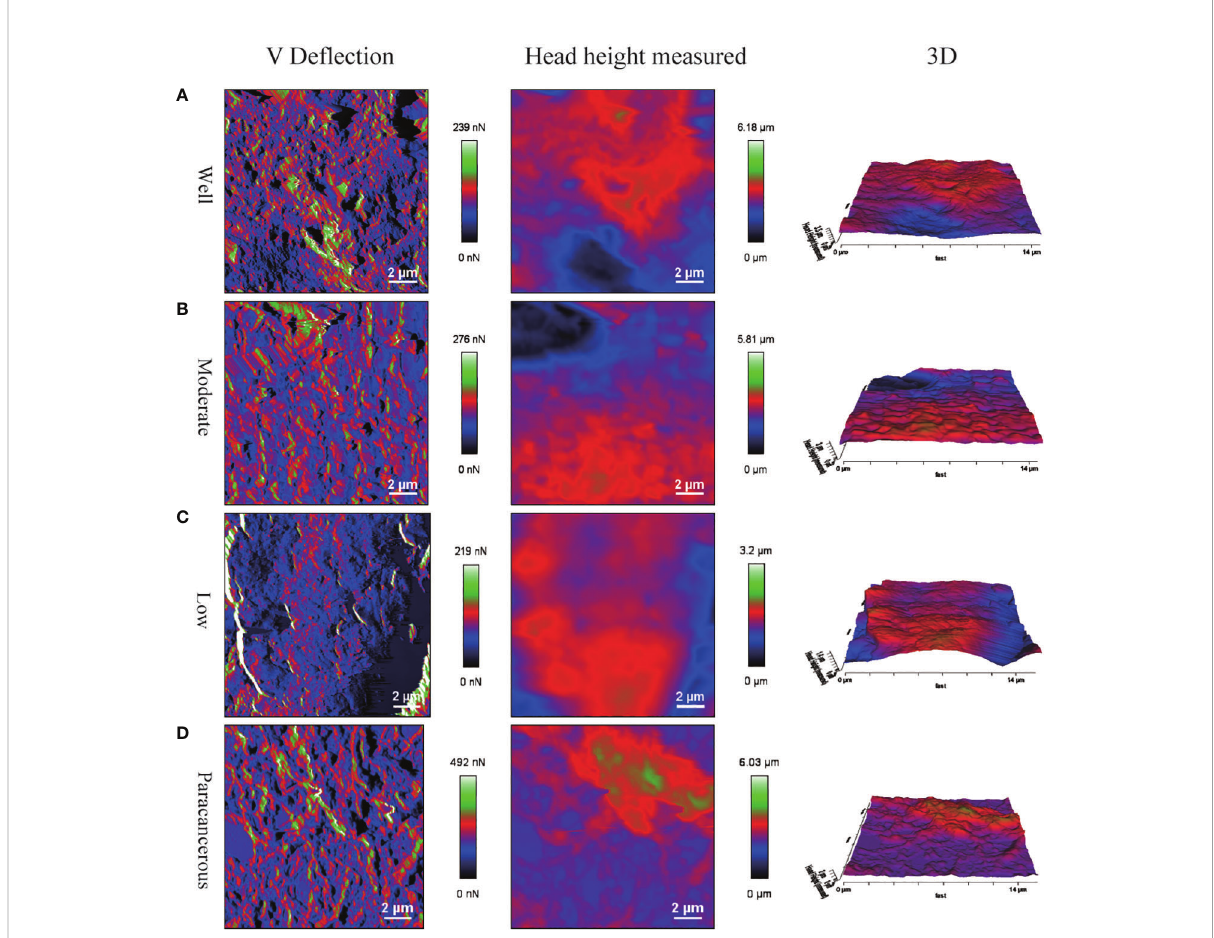
FIGURE 6 Surface morphology of OSCC tissue sections via AFM detection. Poorly differentiated tissues had irregular morphology. (A) V De fl ection, Head height measured and 3D images of well differentiation OSCC. (B) V De fl ection, Head height measured and 3D images of moderate differentiation OSCC. (C) V De fl ection, Head height measured and 3D images of poor differentiation OSCC. (D) V De fl ection, Head height measured and 3D images of paracancerous